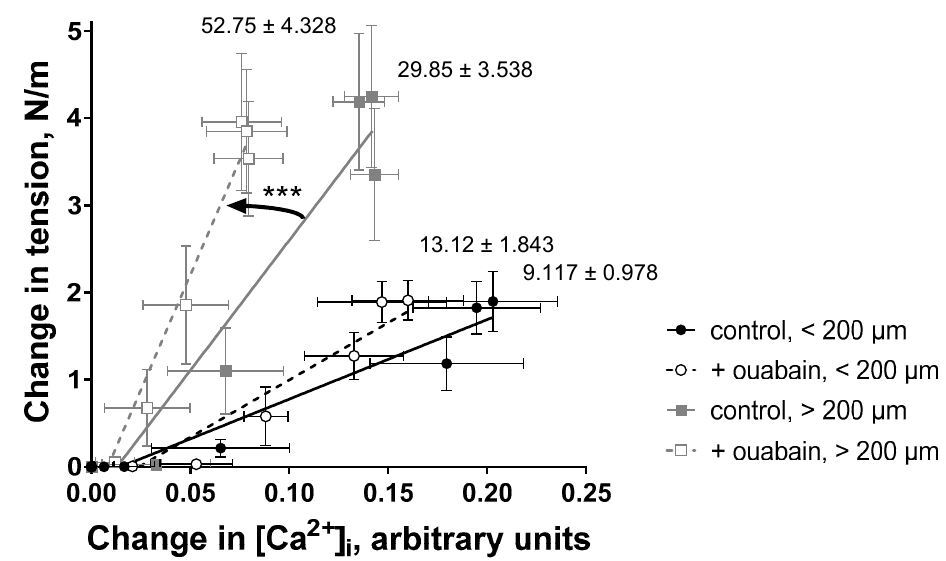
Figure 5. Ouabain has a stronger sensitizing effect on the arteries of large diameter compared to small arteries. Mesenteric arteries were subdivided into two groups; one group consisted arteries with inner diameter below 200 µ m and another group consisted arteries of inner diameter above 200 µ m. Arteries were loaded with the Ca 2+ -sensitive dye (Fura-2/AM) and simultaneous measurements in wall tension ( A ) and [Ca 2+ ] i ( B ) were obtained in the presence of different noradrenaline concentrations. ( C ) shows the changes in wall tension as a function of the changes in [Ca 2+ ] i for different groups under control conditions and in the presence of 10 µ M ouabain, i.e., the data re-plotted from ( A , B ). The slopes of tension–[Ca 2+ ] i relations are indicated as values on the plot. Note, that the steepness of the tension– [Ca 2+ ] i relation was significantly increased for arteries with inner diameter above 200 µm. p < 0.01 (**) and p < 0.001 (***), n = 4–5.